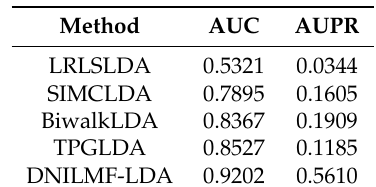
Table 1. AUC and area under precision-recall (PR) curve (AUPR) values of the five models.